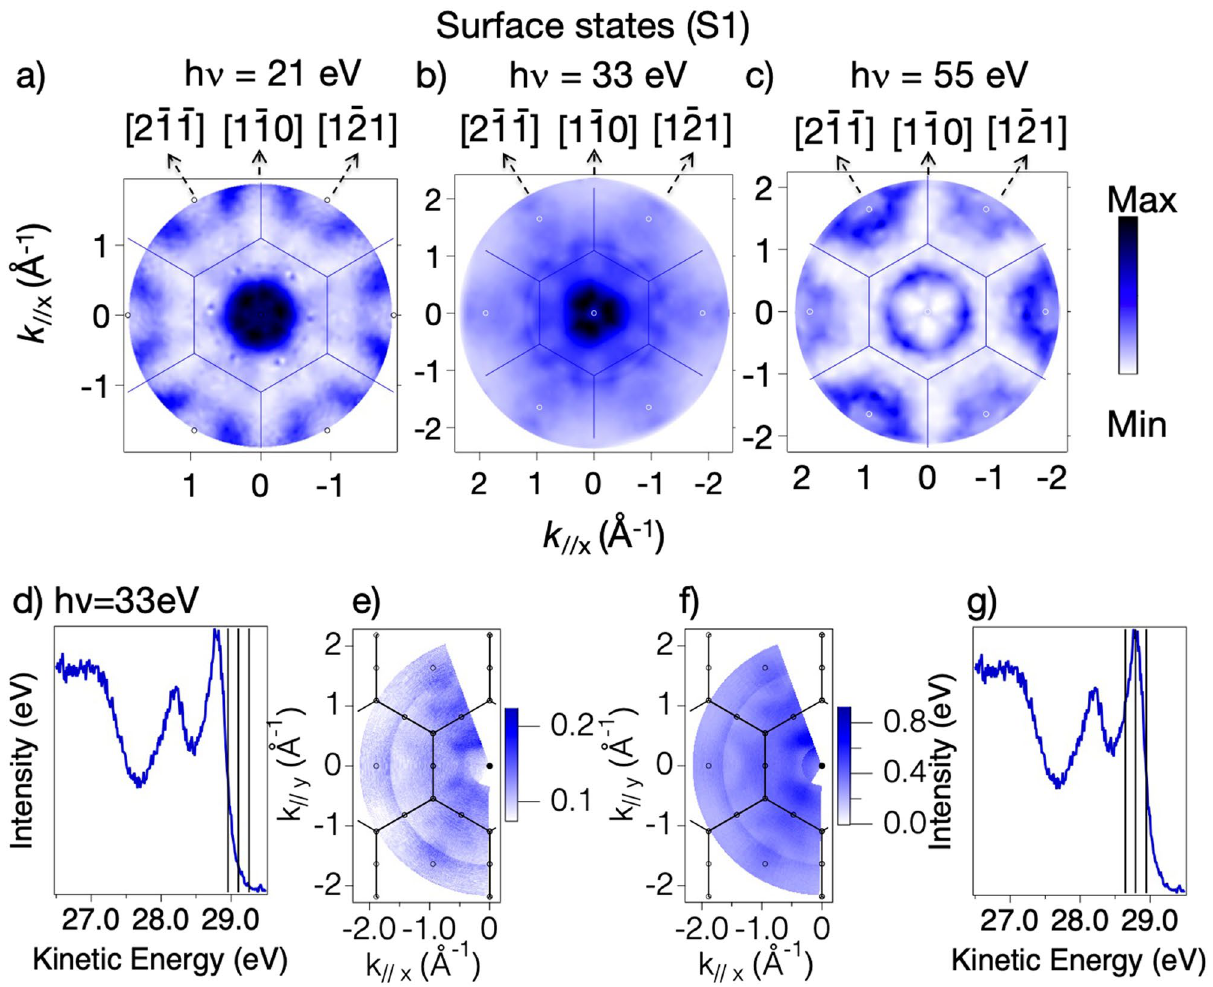
Figure 3. ( a – c ) for map of the intensity of the photoemission from the S1 state as a function of k// recorded at three different photon energies (21 eV, 33 eV and 55 eV respectively). The superimposed lines correspond to the (1 × 1) Brillouin zone boundaries. ( e , f ) compare similar partial maps recorded at 33 eV from emission from the S1 peak ( g ) and from the Fermi level ( d ). Panels ( a – c ) have been recorded using the setup I of Figure S2, while panels ( d – g ) have been measured in the setup II of Figure